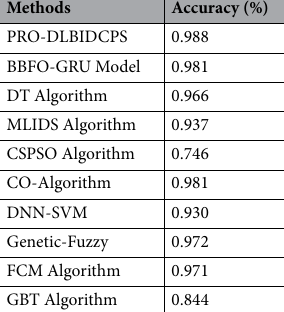
Table 2. Comparative study of PRO-DLBIDCPS technique in terms of accuracy.